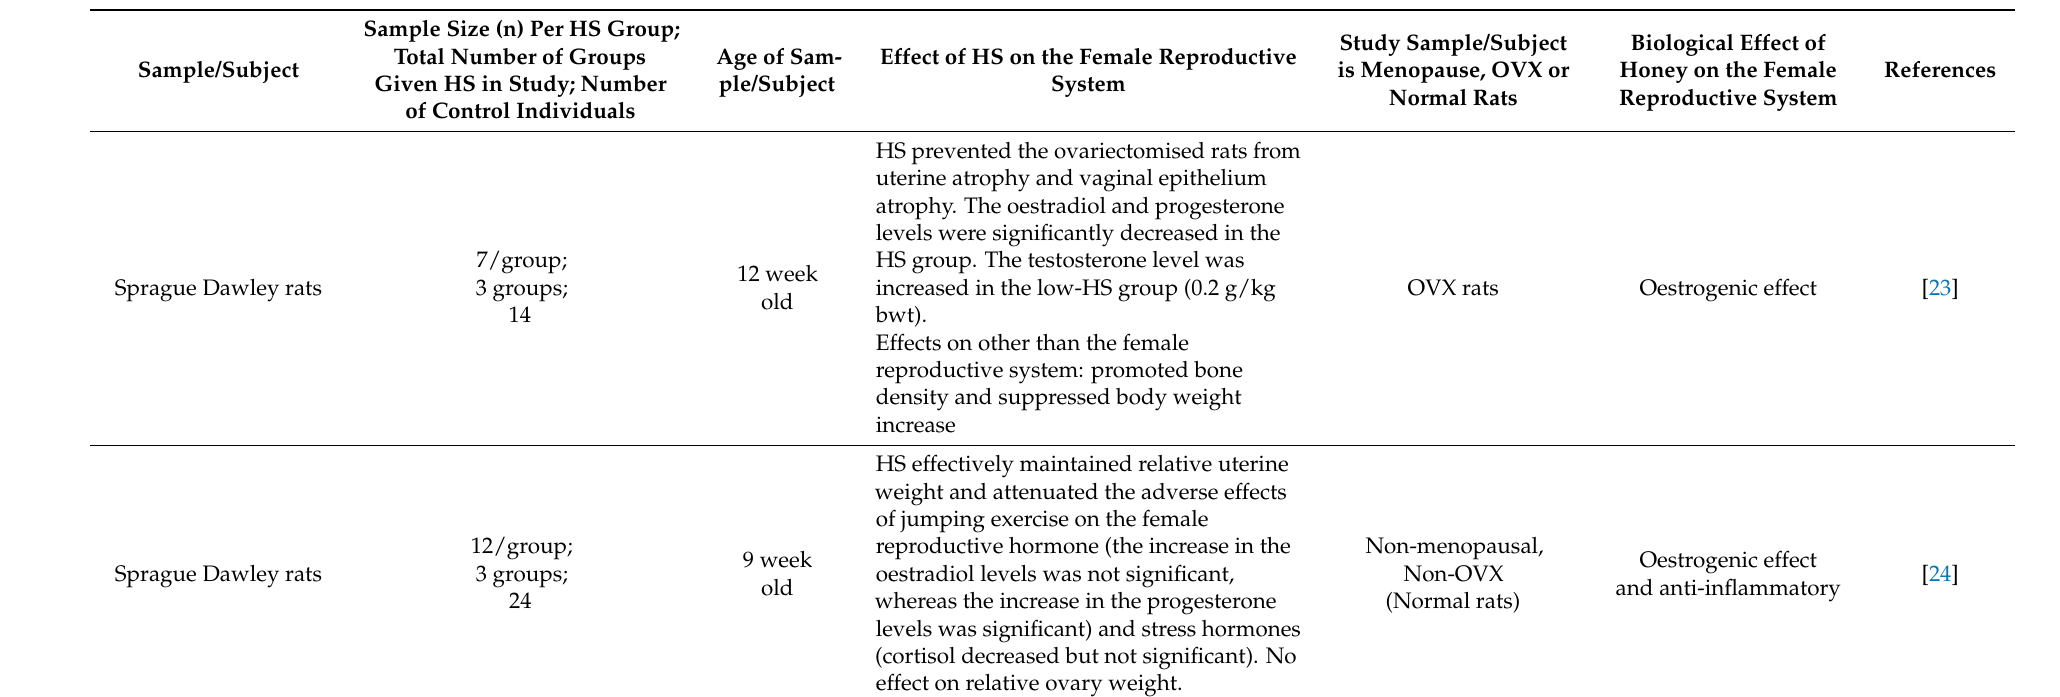
Table 2. Effect of honey supplementation on the female reproductive system in